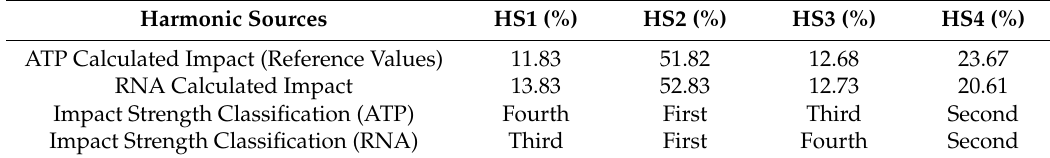
Table 3. Percent impacts on voltage harmonic distortions due to harmonic sources, HS1, HS2, HS3, and HS4, and respective impact strength classification.